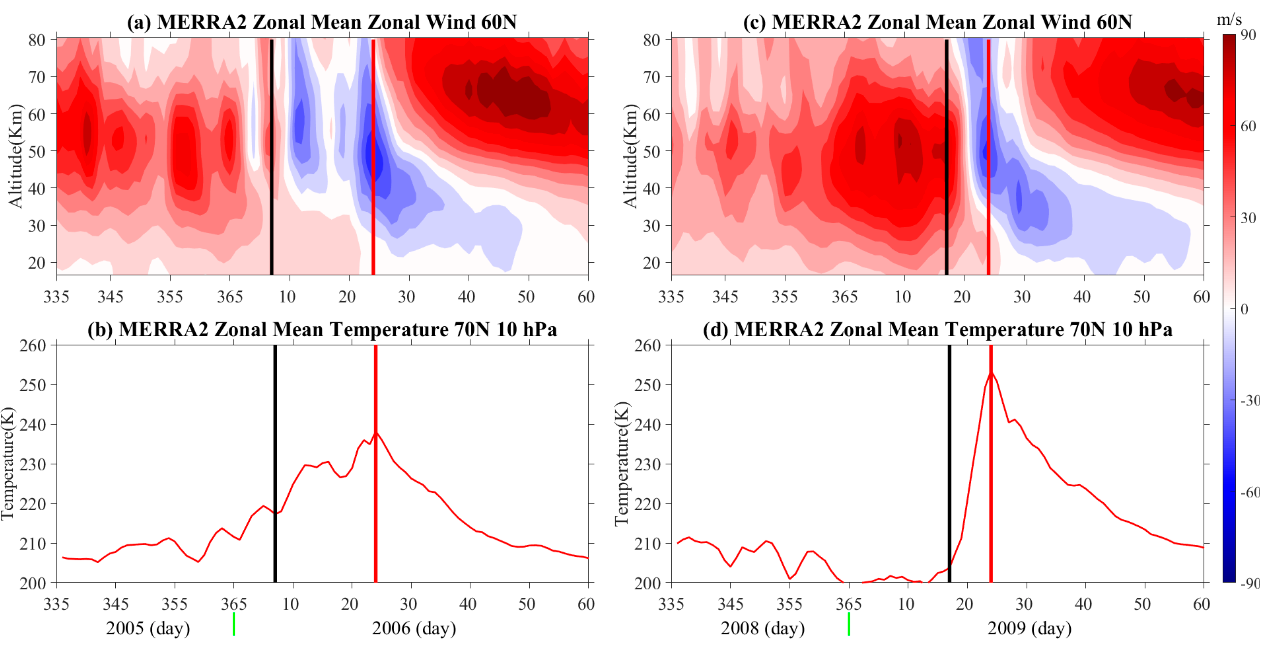
Figure 1. Temporal variations of the ( a , c ) zonal mean zonal wind at 60 ◦ N and ( b , d ) zonal mean temperature at 70 ◦ N and 10 hPa in ( a , b ) 2006 and ( c , d ) 2009. The vertical black and red lines indicate the starting of the sudden stratospheric warming and the warming peak of the sudden stratospheric warming.